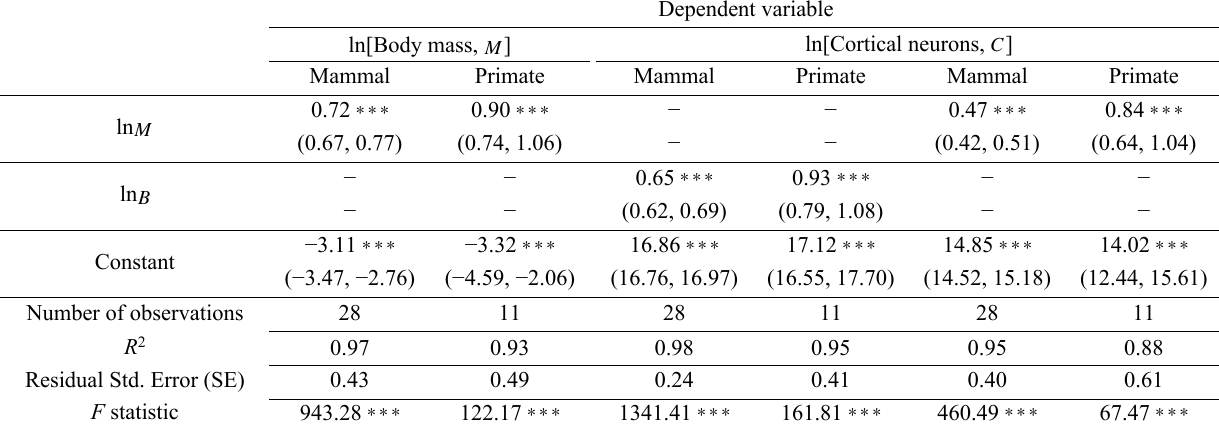
Table 1 Brain mass, cortical mass, and cortical neuron